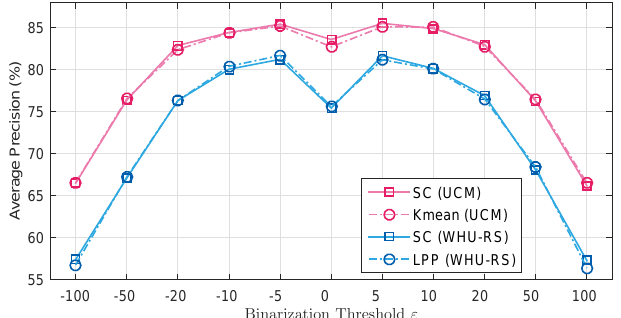
Figure 11. The effect of binarization threshold ε on classification performance. Here, the SC and K-means filters are tested on the UCM dataset; the SC and locality-preserving projection (LPP) filters are tested on the WHU-RS dataset. We evaluate the classification accuracy with 10 filters of a size of 9 9 when the threshold ε varies within a wide range. ×